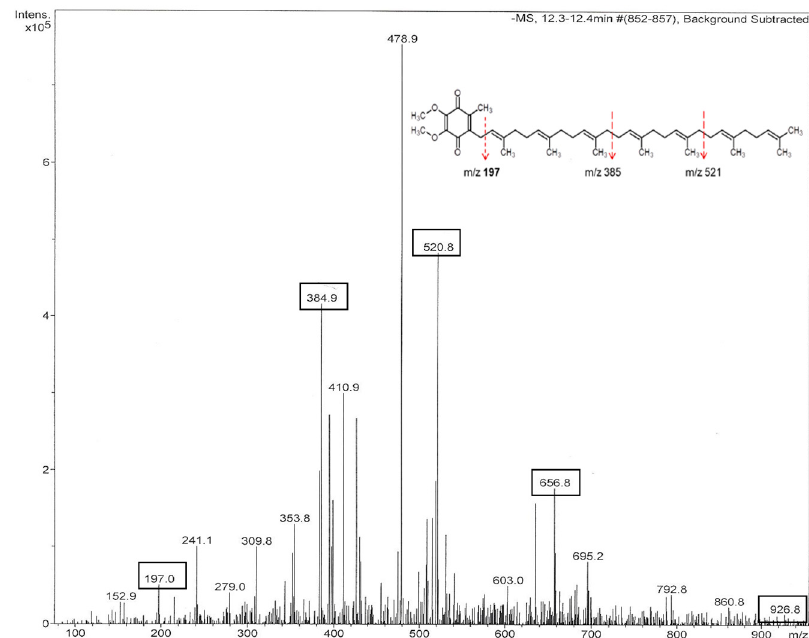
Figure 5. Mass spectrum of fraction F15 of buckwheat honey H177 conducted in the negative ionization mode. The insert provides a general structure of ubiquinone UQ-7, m / z 656.6 and its fragmentation patterns. The product ion spectrum includes m / z 520.8, m / z 384.9 and m / z 197.0.